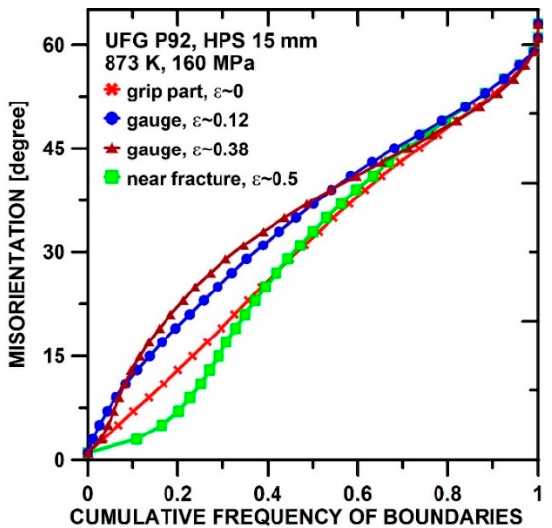
Figure 11. Evolution of misorientation distribution during creep of HPS15.